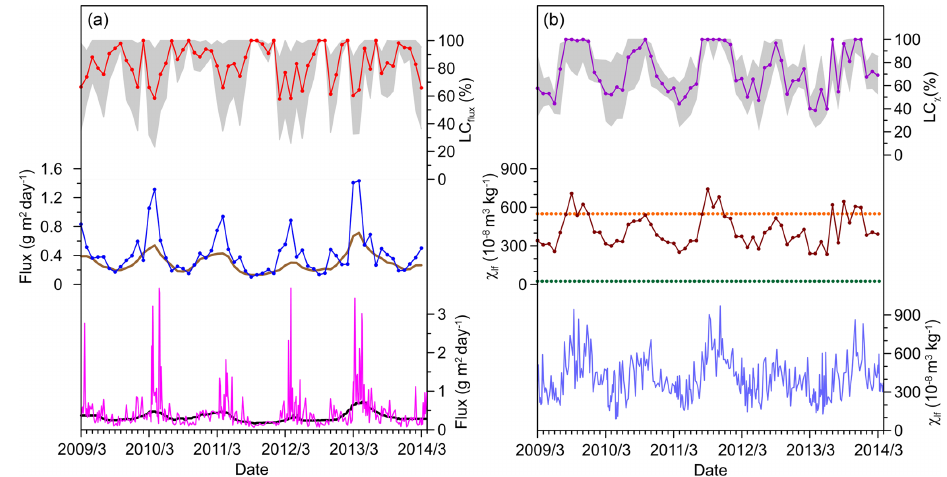
Figure 10. The estimated local contributions by dust flux (a) and χ lf (b) . From bottom to top: (a) dust flux (pink) and background estimate by the running median with a cross-validated number of window points ( k = 19) (black), monthly averaged dust flux (blue) and background (brown), average monthly local contribution (red) estimated by dust flux at XA1, and the uncertainty bounds calculated by standard deviation (gray area). (b) χ lf values (light blue), averaged χ lf values of natural distant dust (green dotted lines), monthly averaged χ lf values (dark red), averaged χ lf values of local street dust (orange dotted lines), monthly local contribution (violet) estimate by χ lf at XA1, and the uncertainty boundaries calculated by standard deviation (gray